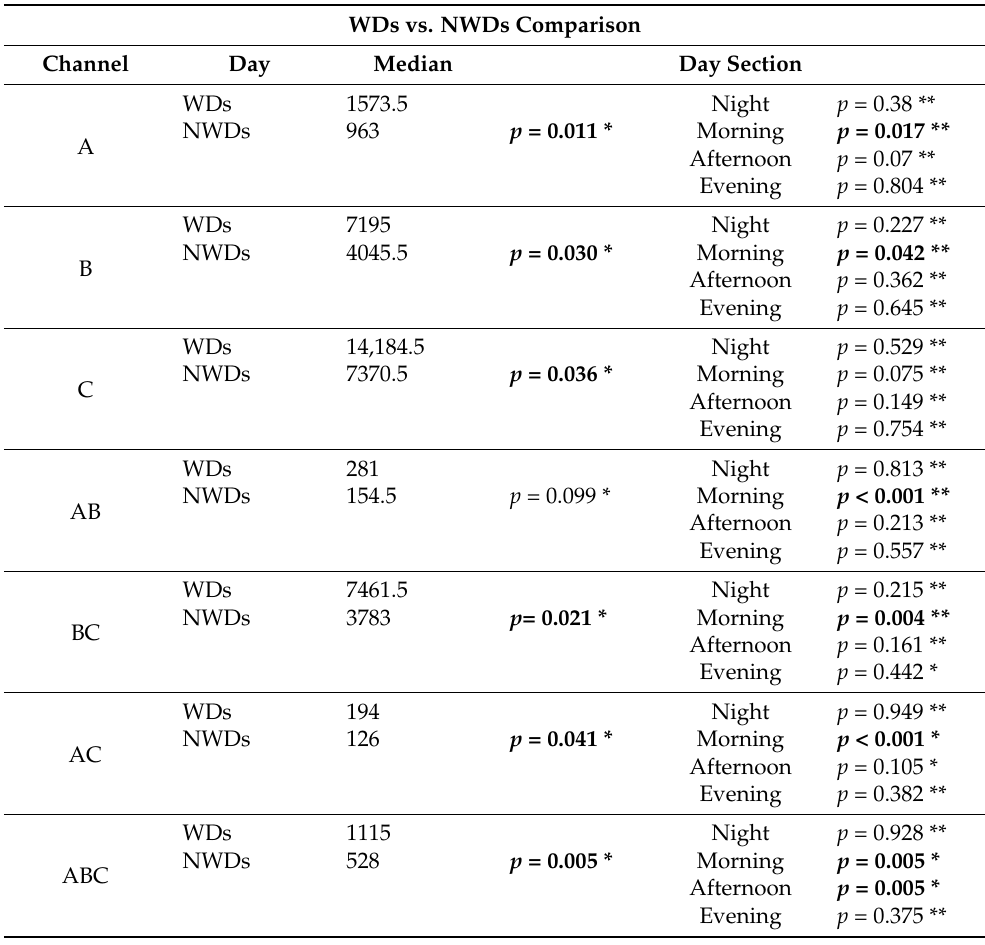
Table 3. Results of the analysis of variance between WDs and NWDs for each channel. Significant results are shown in bold. * Mann-Whitney Rank Sum Test; ** t